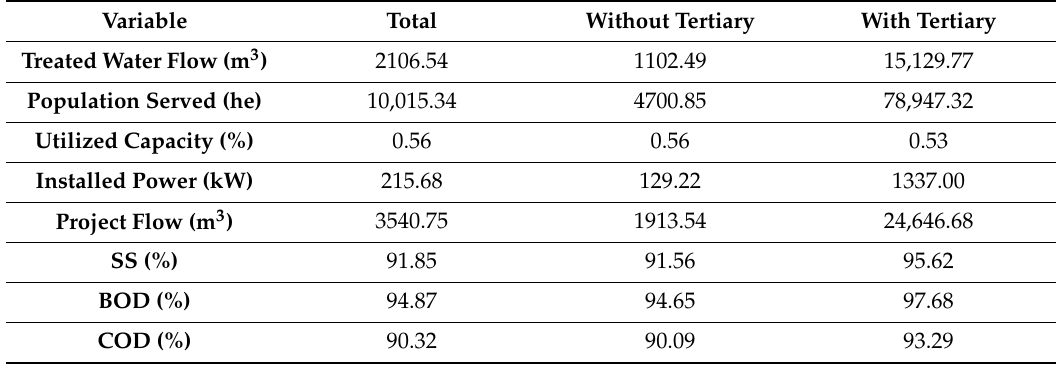
Table 1. Means of the Analysis Variables for the total Treatment Plants and separately for those that have or not Tertiary Treatment.